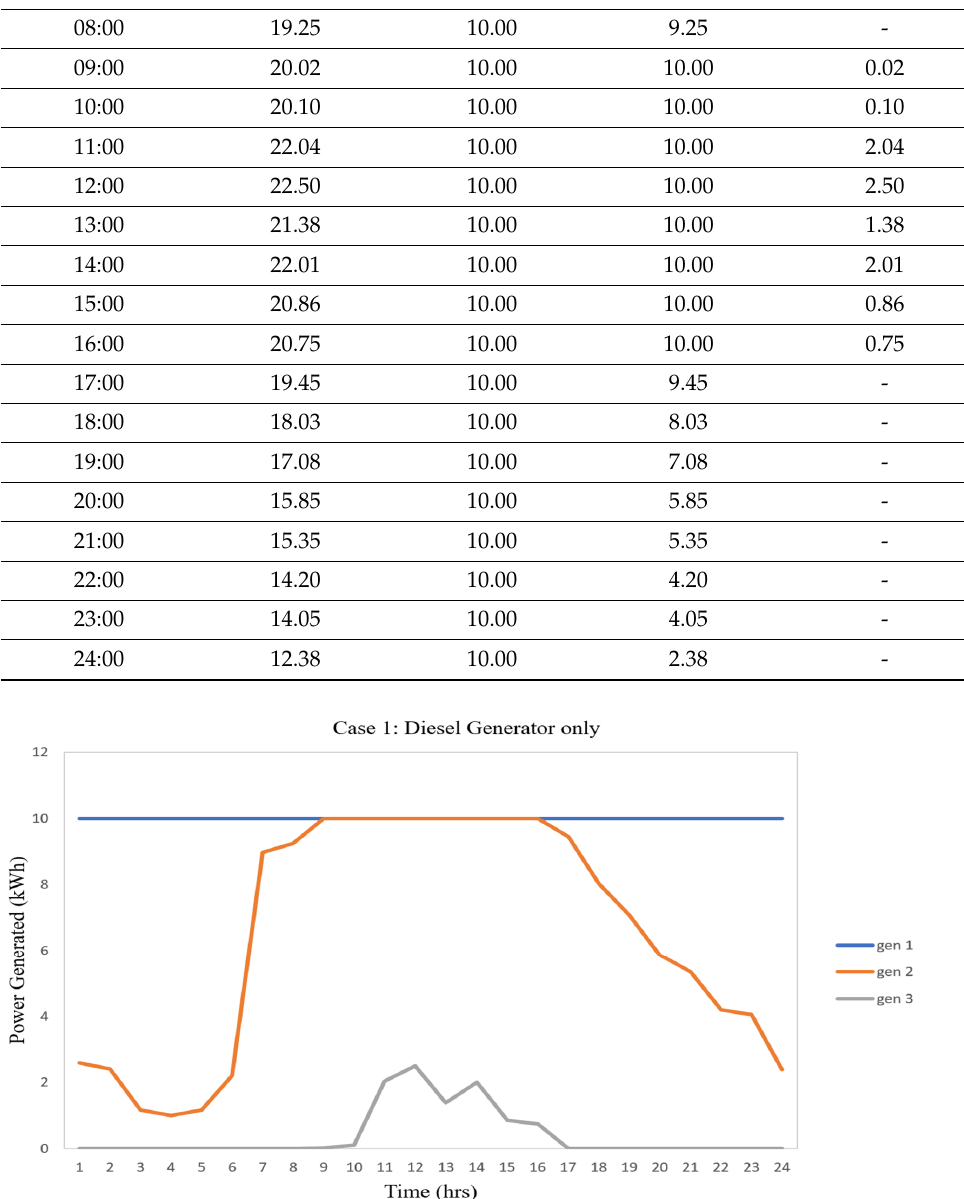
Figure 3. Case 1: power output variation from diesel generators.